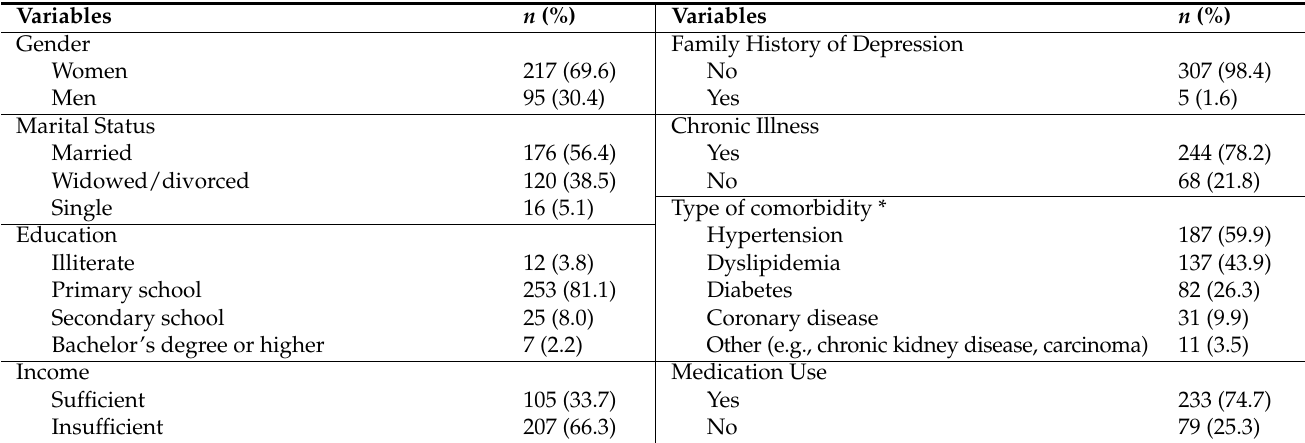
Table 1. Characteristics of study participants ( n =